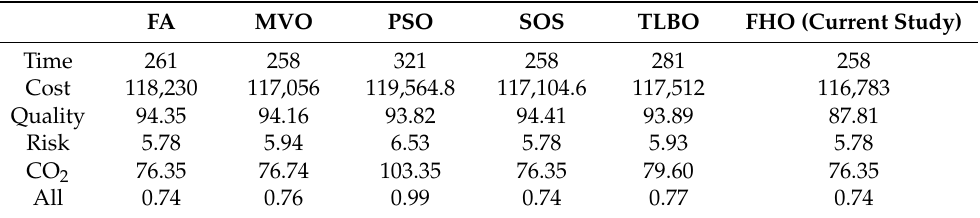
Table 2. The best outcomes of the FHO and alternative algorithms for the case study.